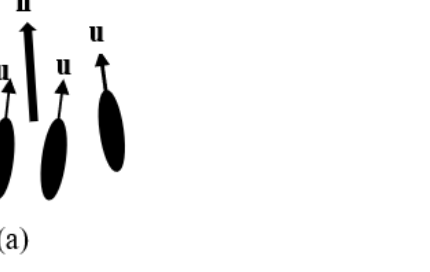
Figure 1. Schematic representation of director n for ( a ) calamitic, ( b ) discotic LCs. Considering the symmetry of the director and taking it to be of unit magnitude, Leslie simplified the equations based on Ericksen’s theory of anisotropic fluids [26]. The constitutive equations were developed incorporating Frank’s theory to model the elasticity of the LCs [27]. The basis of Frank’s elasticity coefficients is that LCs tend to resist and recover from distortion, analogous to the tendency of elastic solids to resist strain [27]. The EL theory is suitable for cases of slow-moving flows, where the flow time scale is